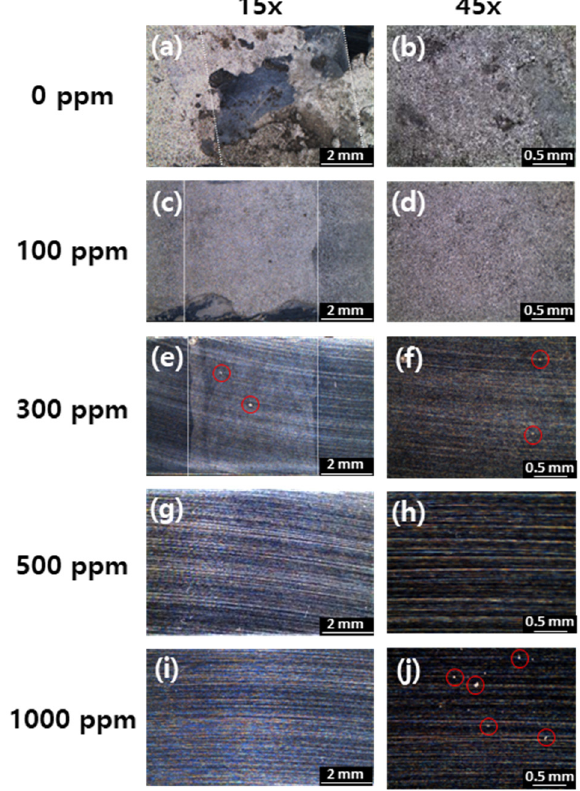
Figure 6. Optical microscopy images (15×) of carbon steel weldment after 40 h immersion in the solution with addition of ( a ) 0 ppm, ( c ) 100 ppm, ( e ) 300 ppm, ( g ) 500 ppm, and ( i ) 1000 ppm of imidazole and magnified images (45×) of ( b ) 0 ppm, ( d ) 100 ppm, ( f ) 300 ppm, ( h ) 500 ppm, and ( j ) 1000 ppm of imidazole; white dotted lines show weldment area and red circles show micro-scale pitting.